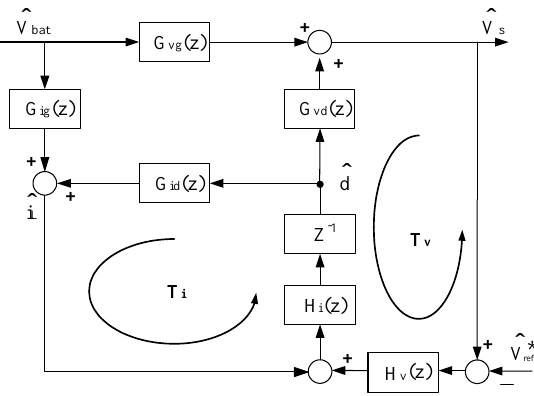
Figure 9. Small-signal block diagram for two-loop control.